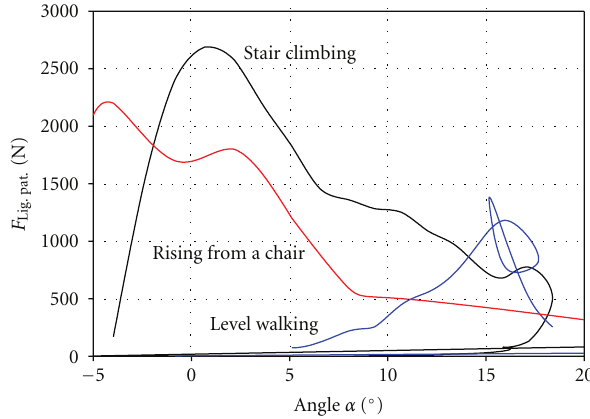
Figure 3: Load regimes for di ff erent activities.